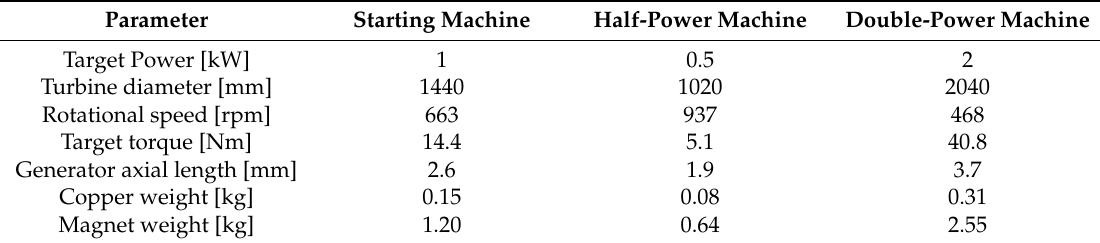
Table 3. Results of the scalability procedure.